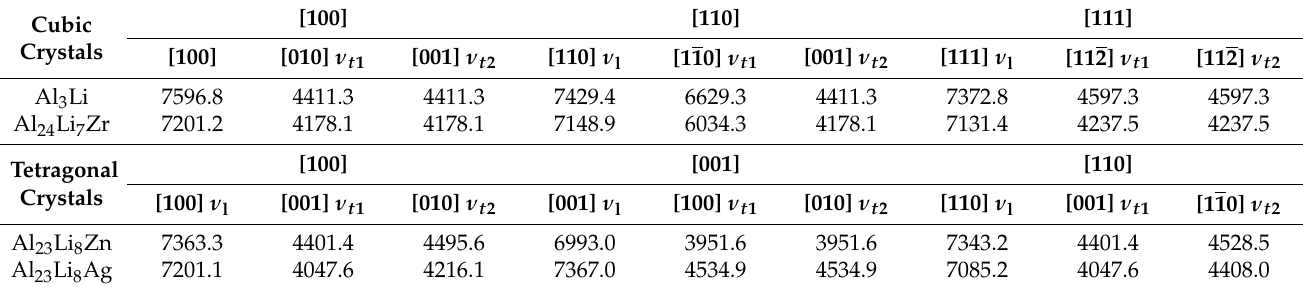
Table 5. The calculated anisotropic sound velocities (m/s) of pure and doped Al 3 Li